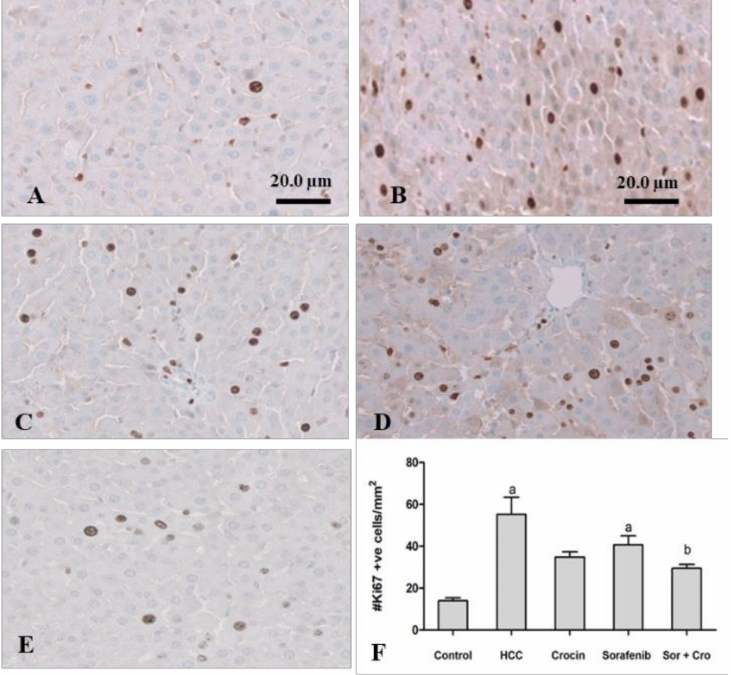
Figure 3. Antitumor effect of crocin and sorafenib on cell proliferation. Representative images of immunohistochemical staining with Ki-67 in control group ( A ). HCC group ( B ). crocin-treated group ( C ). sorafenib-treated group ( D ), and Crocin/sorafenib treated group ( E ). Panel ( F ) shows the quantitative analysis of Ki-67 immunoreactive cells in 10 fields of each section of the Ki-67 positive foci and quantitative region analysis of the Ki-67–positive foci × 100 magnification (Scale bar 20 µ m). The values were evaluated by one-way ANOVA followed by Dunnett’s t -test compared to the HCC- induced group. Data are represented as mean ± SEM. The letter (a) is used for p < 0.05 vs. control group and the letter (b) is used for p < 0.05 vs. HCC